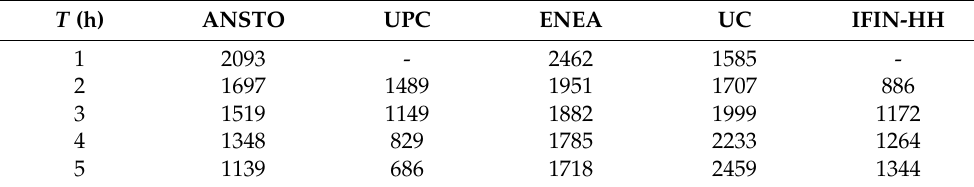
Figure 9. Radon activity concentration over the first 5 h of the static accumulation period during the high radon flux area campaign (from point A of Figure 8). Table 4. Radon flux E (Bq m − 2 h − 1 ) obtained from the linear fit applied over a static accumulation experiment considering some time period T for each device.